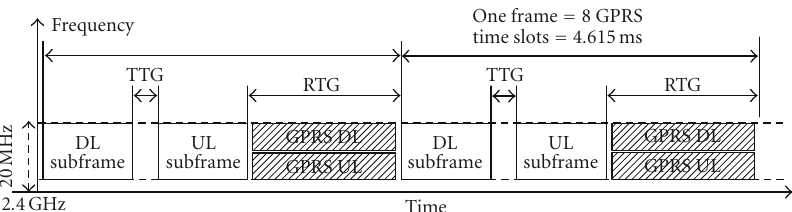
Figure 12: GPRS and WiMAX time sharing the ISM band.